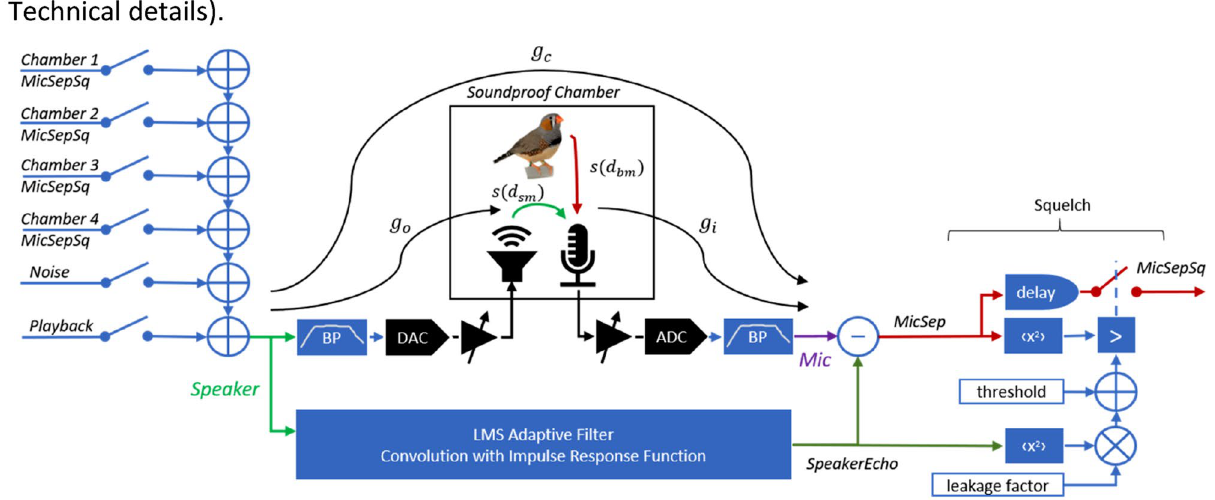
Figure 3. Block diagram for one chamber showing the digital signal processing blocks on the FPGA (blue) and analog devices (black). To compose the Speaker signal (green, left) destined to the loudspeaker, we selectively added signals from other chambers with playback and noise signals that we then band-pass (BP) filtered. Because the microphone picks up the signals from both the bird (red) and the loudspeaker (green), we subtracted from the Mic signal (purple) the speaker component (SpeakerEcho) that we estimated with a least mean square (LMS) adaptive filter, resulting in the separated bird signal in the chamber (MicSep). A subsequent squelch passed the MicSep signal only when its intensity was above a threshold. The threshold was the sum of a constant value and a dynamic part that was proportional to the intensity of the SpeakerEcho signal. The dynamic threshold provided robustness to unwanted sound leakage from an imperfect echo attenuation with the LMS filter. To avoid cutting vocalization onsets, we introduced a delay of the MicSep signal into the squelch. The resulting chamber output signal was the separated and squelched microphone signal (MicSepSq). Indicated by curved arrows are the gain g o of the output chain, the gain g i of the input chain, and the chamber gain g c